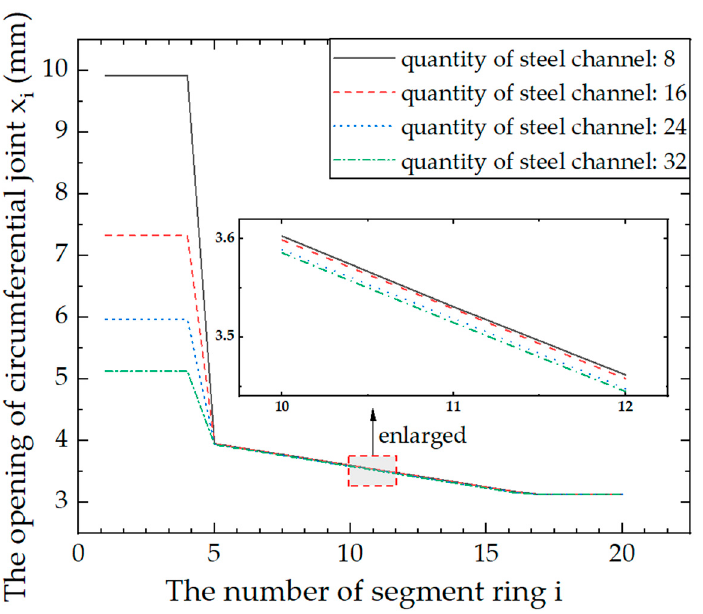
Figure 16. The relationship curve between the opening of circumferential joints and the number of rings under different quantity.